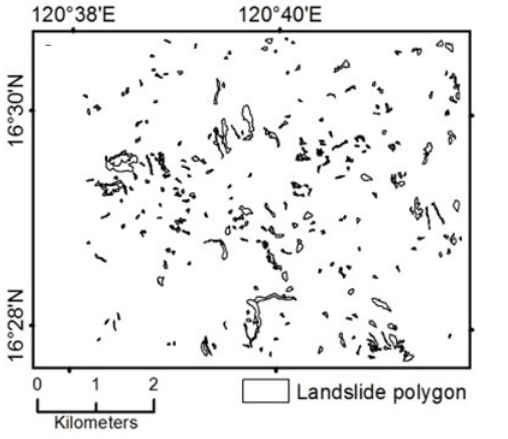
Figure 3. Three hundred five landslides (with area > 900 m 2 ) used in modelling landslide